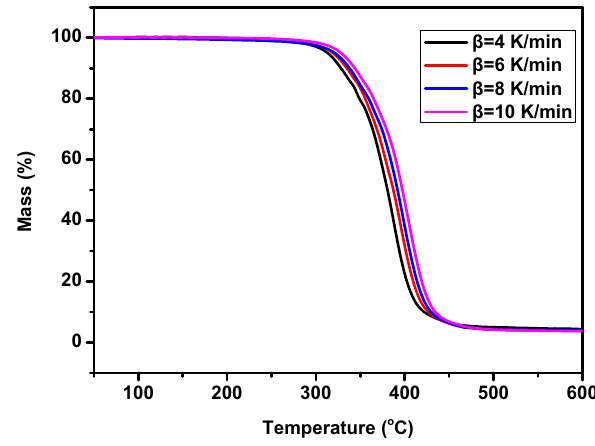
Figure 2: TG curves of polyacrylate PSA at di ff erent heating rates.